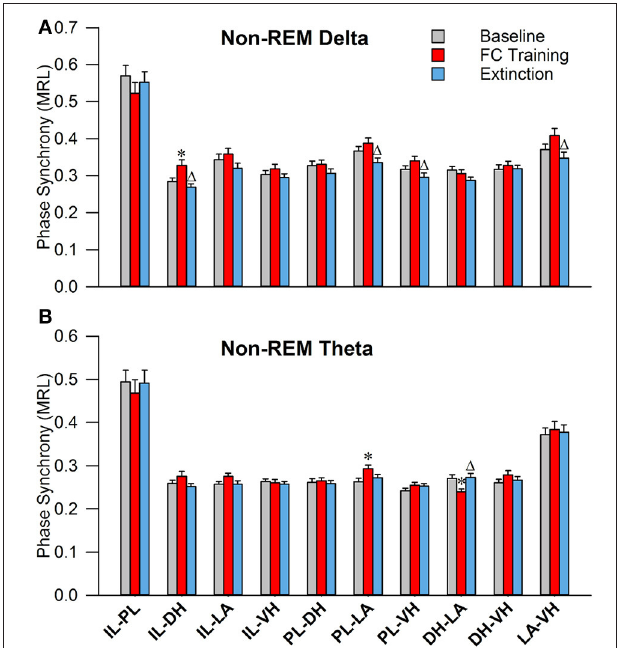
FIGURE 6 | Synchrony during Non-REM Sleep following Fear Conditioning and Extinction. Bar plots displaying PLV of delta (A) and theta (B) synchrony during non-REM sleep following fear conditioning (red) and extinction (blue). In delta rhythms, IL-DH synchrony increases following fear conditioning, compared to both baseline and extinction. Also, synchrony is increased between the PL-LA, PL-VH, and LA-VH pairings following fear conditioning, compared to extinction. In theta rhythms, we see synchrony increases following fear conditioning between the PL-LA pairings, compared to baseline. Interestingly, we see DH-LA synchrony decrease following fear conditioning, compared to both baseline and extinction. *denotes significant difference ( p < 0.05) compared to baseline, and 1 denotes significant difference ( p < 0.05) compared to fear conditioning. IL, infra-limbic; PL, pre-limbic; DH, dorsal